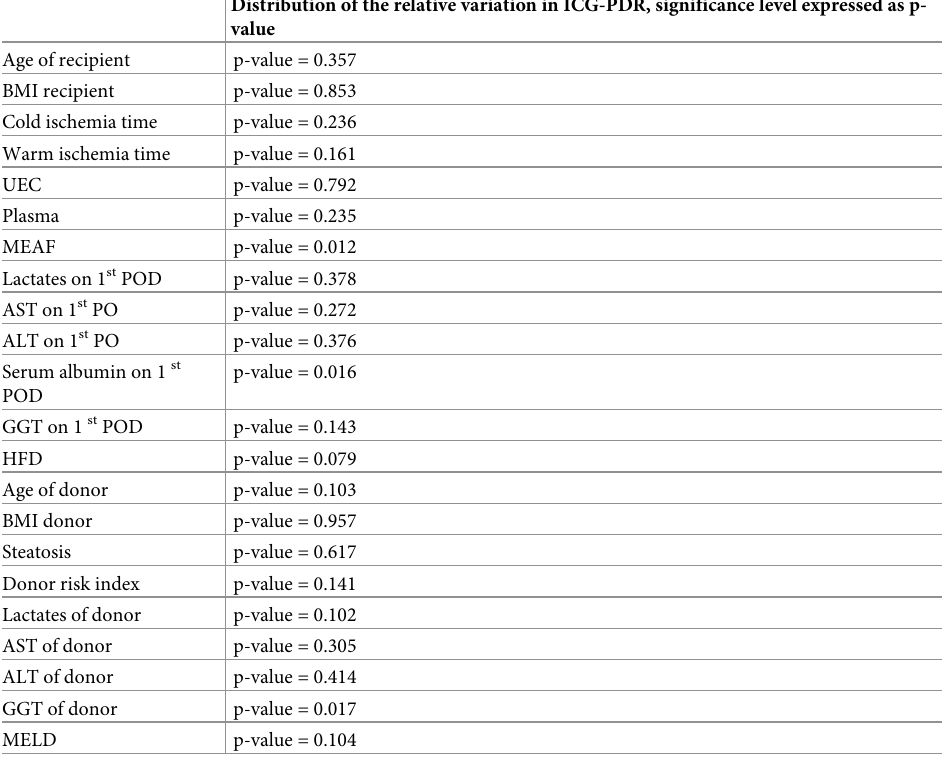
Table 4. Association between variables and the distribution of the relative variation in ICG-PDR.